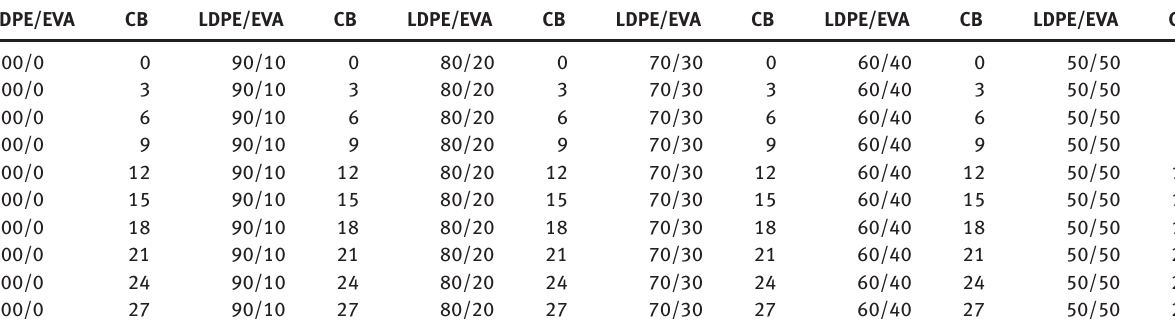
Table 1: Carbon black content (in wt%) of the composite.